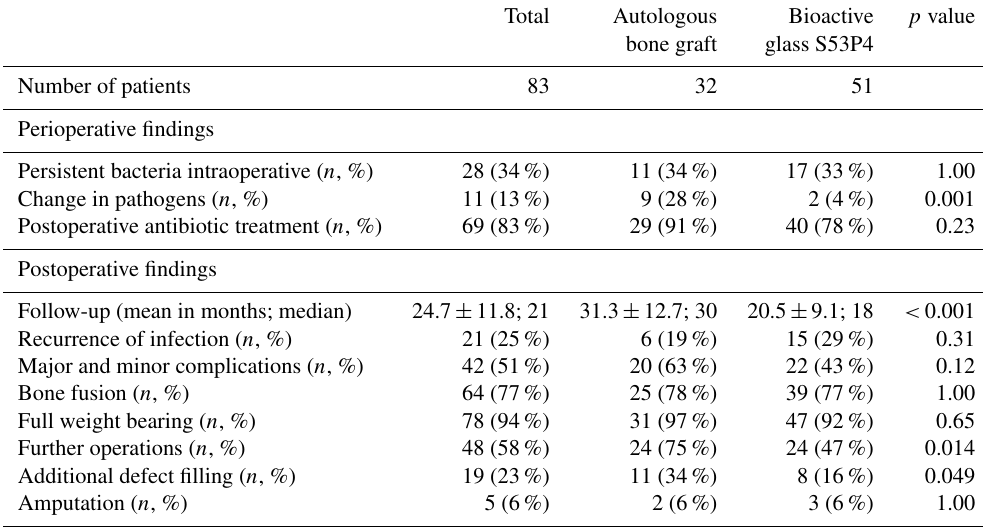
Table 3. Peri- and post-operative